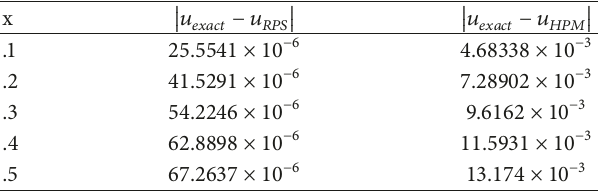
󵄨󵄨󵄨󵄨𝑢 󵄨󵄨󵄨󵄨 󵄨󵄨󵄨󵄨𝑢 − 𝑢 𝑒𝑥𝑎𝑐𝑡 𝑅𝑃𝑆